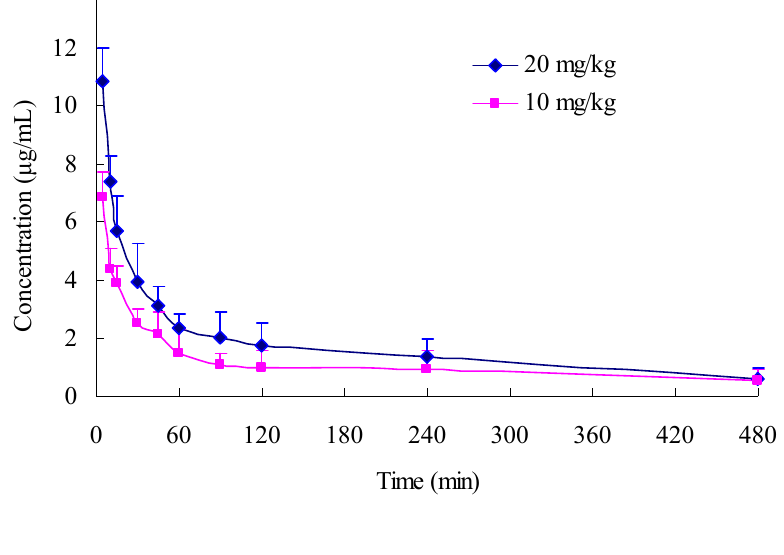
Figure 3. Plasma concentration-time profiles of PD following i.v. administration in rats at doses of 10 and 20 mg/kg ( n =